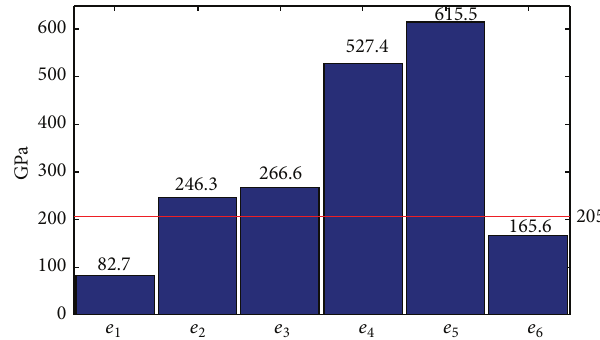
Figure 7: The modulus of elasticity values before and after